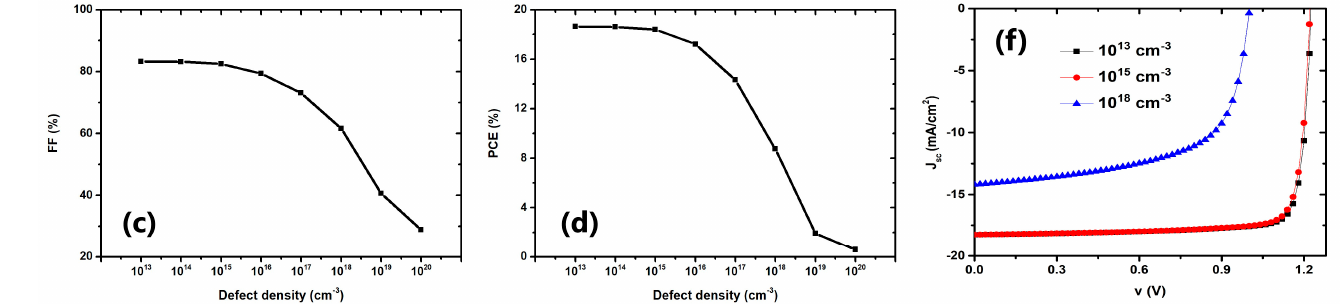
Figure 7. ( a – d ) Variation in the PV parameters of C 2 N with defect density. ( e , f ) QE and current- voltage curve (J-V) behavior with varied C 2 N-defect density.